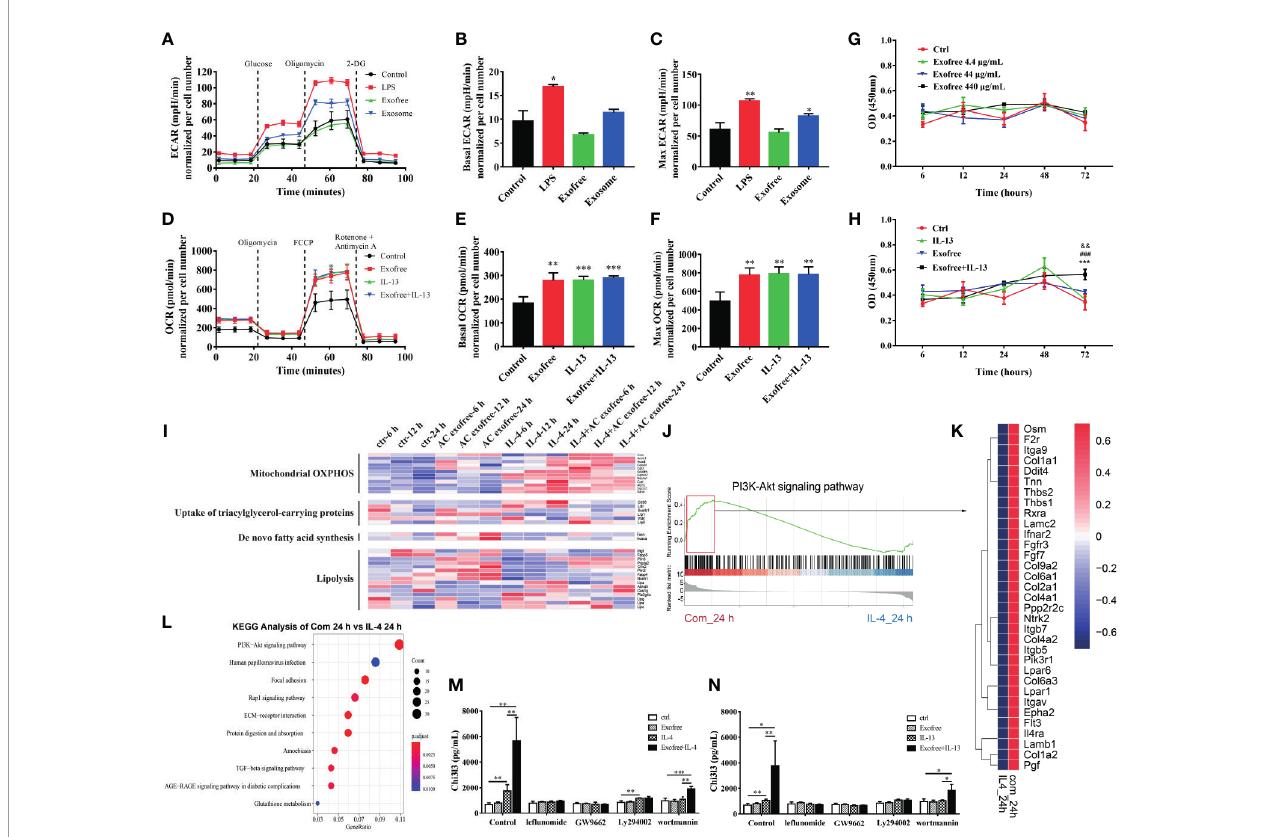
FIGURE 4 | Metabolic Reprogramming by the PI3K-Akt pathway plays a vital role in AC L4 exofree – induced M2 polarization of macrophages. (A – C) BMDMs were cultured for 24 h in medium alone or treated with LPS, exofree, exosome, and then the ECAR (A) was monitored using the Seahorse Bioscience extracellular fl ux analyzer in real time. Dotted lines indicate incubation of cells with the indicated compounds. Basal ECAR (B) and Max ECAR (C) of BMDMs were calculated. *P <0.05, **P <0.01, compared with the control group. In this experiment, LPS concentration is 0.05 m g/ml, AC L4 exosome concentration is 25 m g/ml, and AC L4 exofree concentration is 44 m g/ml. (D – F) BMDMs were cultured for 24 h in medium alone or treated with exofree, IL-13, or exofree+IL-13, and then the OCR (D) was monitored using the Seahorse Bioscience extracellular fl ux analyzer in real time. Dotted lines indicate incubation of cells with the indicated compounds. Basal OCR (E) and Max ECAR (F) of BMDMs were calculated. **P <0.01, ***P <0.001, compared with the control group. In this experiment, IL-13 concentration is 10 ng/ml, and AC L4 exofree concentration is 44 m g/ml. (G, H) Proliferation of BMDMs was determined with CCK8 assay at 6, 12, 24, 48, 72h after treatment of PBS and exofree (G) . AC L4 exofree concentration in this experiment is 4.4, 44, 440 m g/ml. (H) Proliferation of BMDMs was determined with CCK8 assay at 6, 12, 24, 48, 72h after treatment of PBS, IL-13, exofree, IL-13+exofree. In this experiment, AC L4 exofree concentration is 440 m g/ml, and IL-13 concentration is 10 ng/ml. && P <0.01, compared with the control group; ### P <0.001, compared with the IL-13 group; ***P <0.001, compared with the exofree group. (I) Gene expression pro fi le of BMDMs related to mitochondrial OXPHOS, nutrient uptake, de novo fatty acid synthesis, and lipolysis metabolism process were shown in a heatmap. BMDMs were treated with PBS (ctr), free (AC L4 exofree), IL-4, com (IL-4+AC L4 exofree) for 6, 12, and 24 h, respectively. The horizontal axis represents genes, and vertical coordinates represent types of treatment. In this experiment, AC L4 exofree concentration is 440 m g/ml, and IL-4 concentration is 10 ng/ml. (J) GSEA analysis of genes enriched in PI3K-Akt signaling pathway was performed using R package “ clusterpro fi ler. ” (K) Signature genes enriched in PI3K-Akt signaling pathway through GSEA analysis were shown in a heatmap. (L) GO enrichment analysis (biological process) of highly expressed genes in the presence of IL-4 and AC L4 exofree, compared with IL-4 treatment, was performed using R package “ clusterpro fi ler. ” (M, N) BMDMs were treated with PBS, exofree, IL-13, IL-13+exofree (M) , and PBS, exofree, IL-4, IL-4+exofree (N) in the presence of le fl unomide (a STAT6 inhibitor), GW9662 (a PPAR g antagonist), Ly294002 (PI3K inhibitor), and wortmannin (PI3K inhibitor) for 24 h. The protein levels of Chi3l3 in the culture medium were measured using ELISA. The following reagents were used in this experiment: Le fl unomide (100 m M), Ly294002 (10 m M), Wortmannin (100 nM), GW9662 (1 m g/ml). *P <0.05, **P